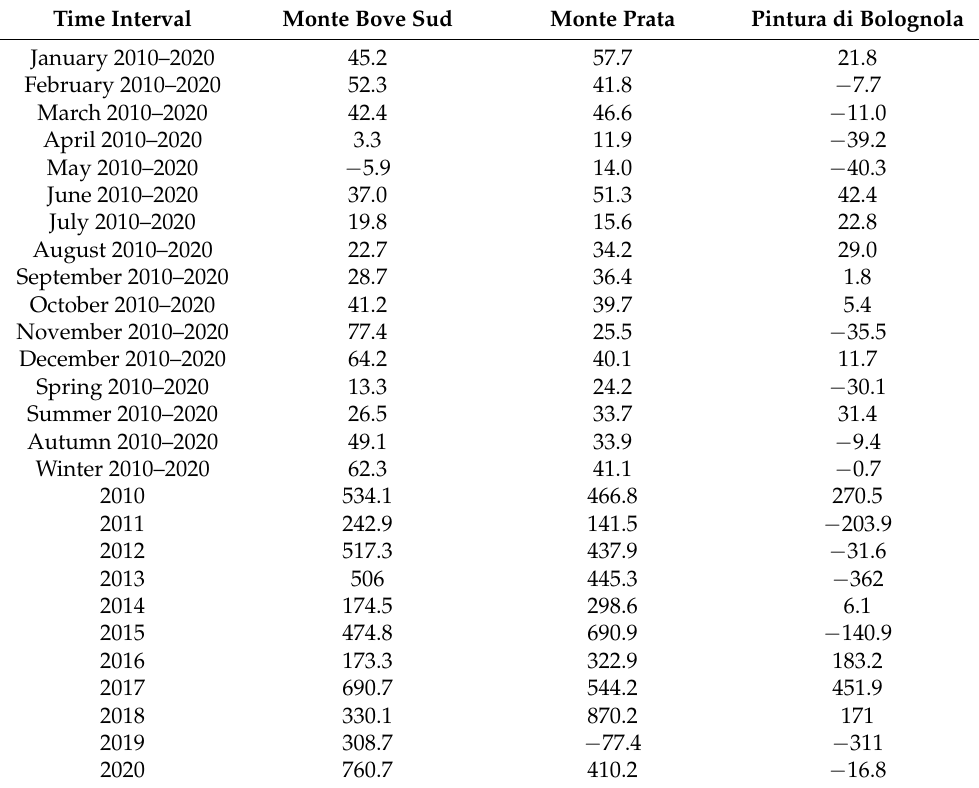
Table 2. Monthly and year-on-year average difference between IMERG data and data from analysed rain gauges; the unit of measurement is mm. Time Interval Monte Bove Sud Monte